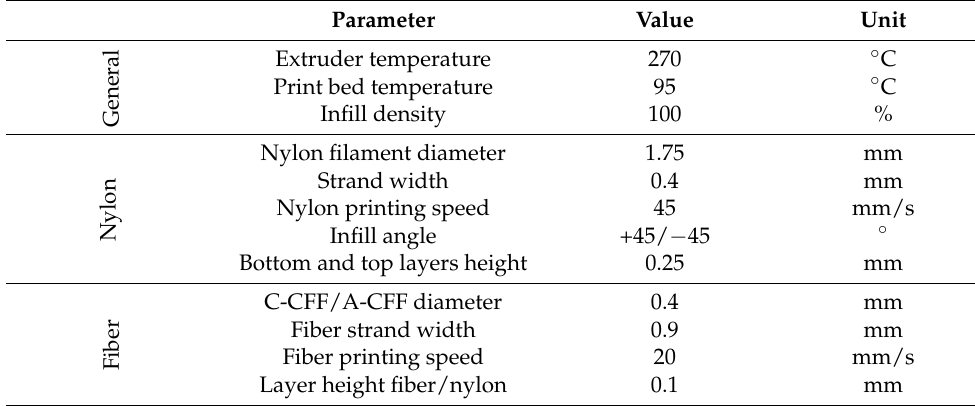
Table 1. Process parameters for the fabrication of the specimens from nylon and continuous car- bon/aramid fiber.